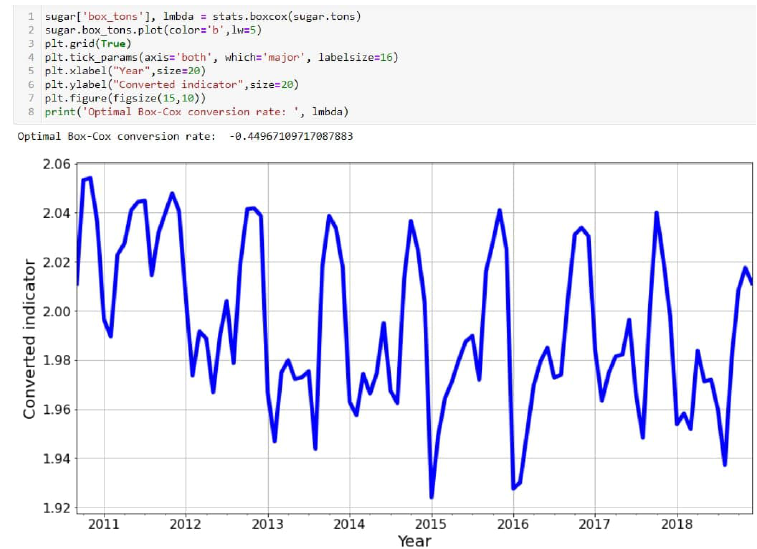
Figure 5. Time series transformation using the Box–Cox test.